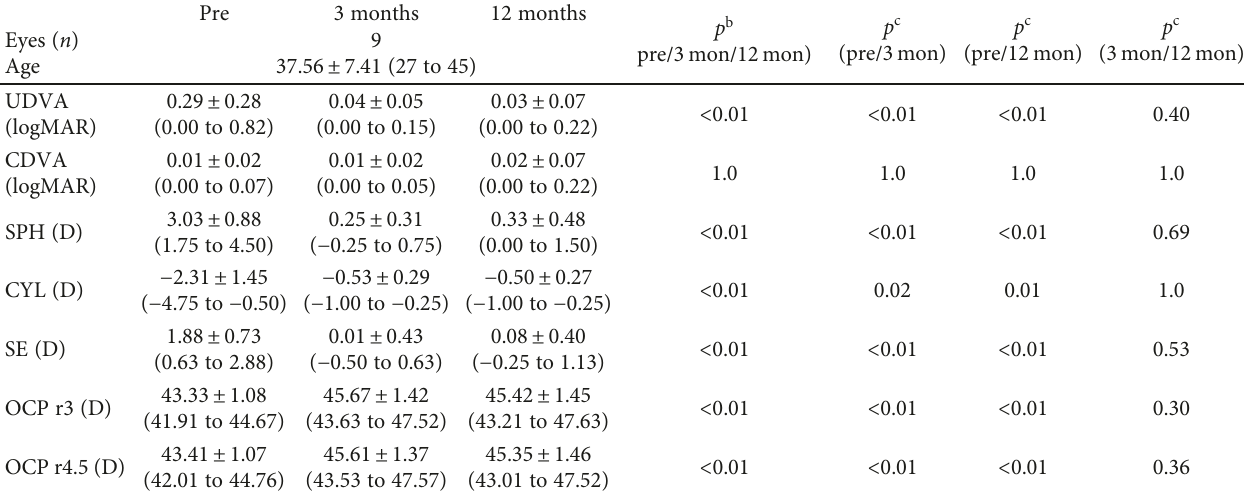
Table 2: Preoperative and postoperative visual, refractive, and objective outcomes 12 months after hyperopic LASIK a,b,c (group 1, SE ≤ 3). Pre